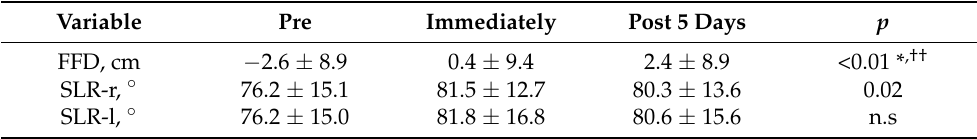
Table 2. Effects of MFR intervention on physical function and performance (n =